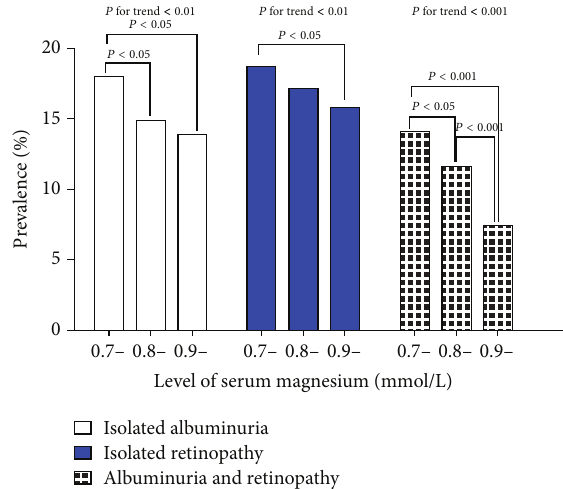
Table 3: Clinical characteristics correlated with serum Mg